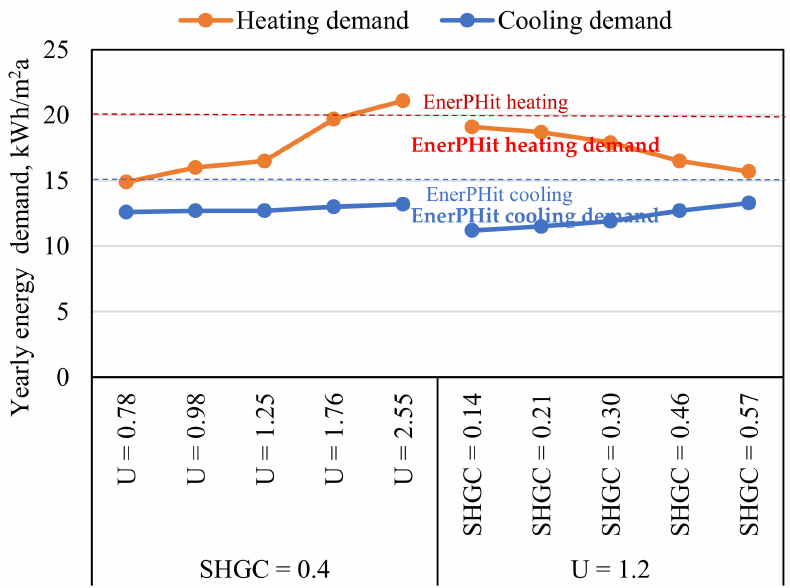
Figure 6. Parametric analysis of the impact of different U-values and SHGC glazing types on the building’s heating demand and cooling